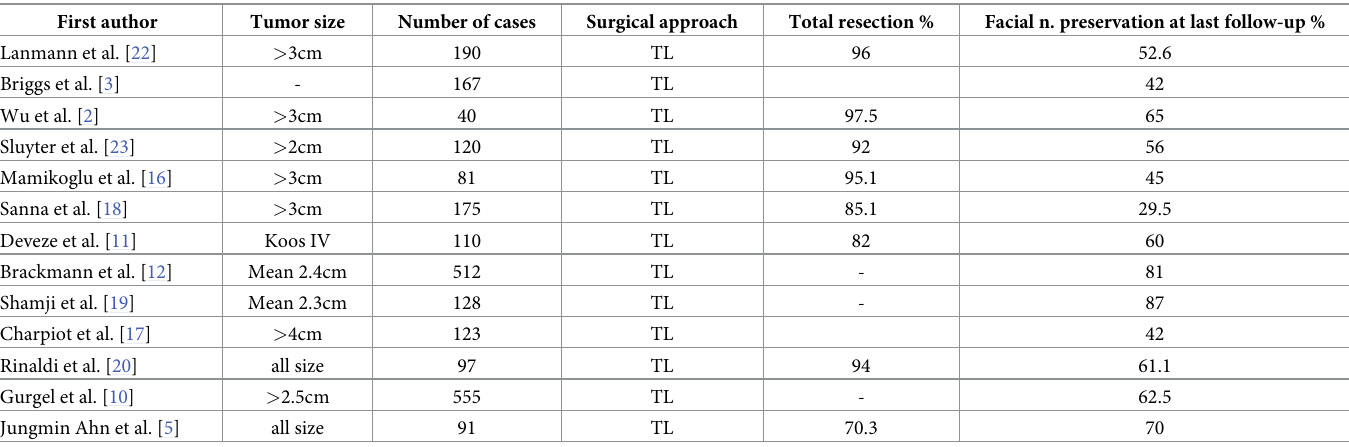
Table 4. Review of articles for facial nerve